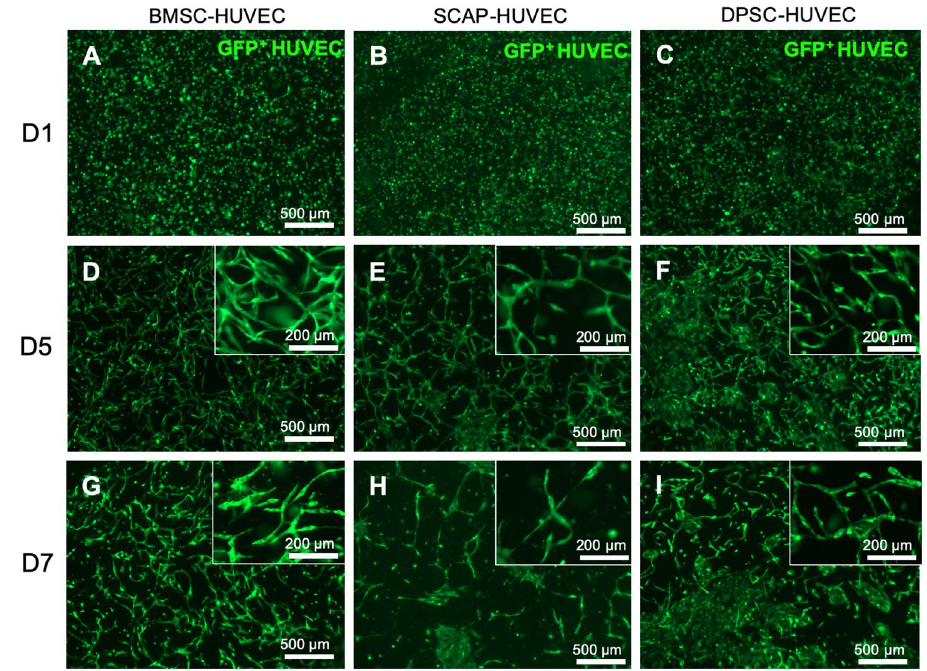
Figure 3. ( A , D , G ) DPSC-HUVECs, ( B , E , H ) BMSC-HUVECs, and ( C , F , I ) SCAP-HUVECs formed vascular networks. BMSC-HUVECs formed dense vascular networks by day 5 ( E ). After the pericyte formation, BMSC system remained the same ( F ), however, the DPSC ( G ) and SCAP ( I ) showed cell island formation along with vascular networks.